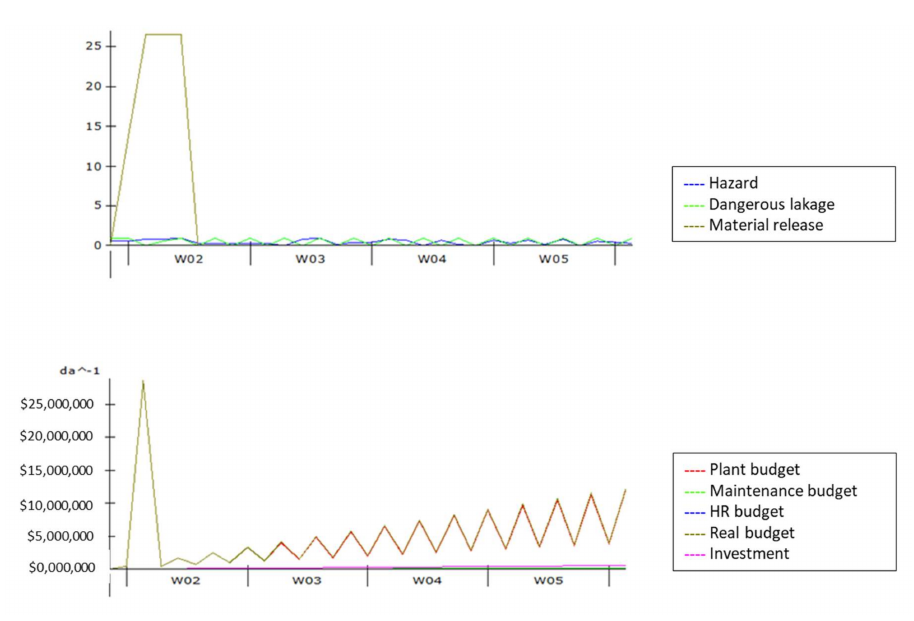
Figure 12. Economic